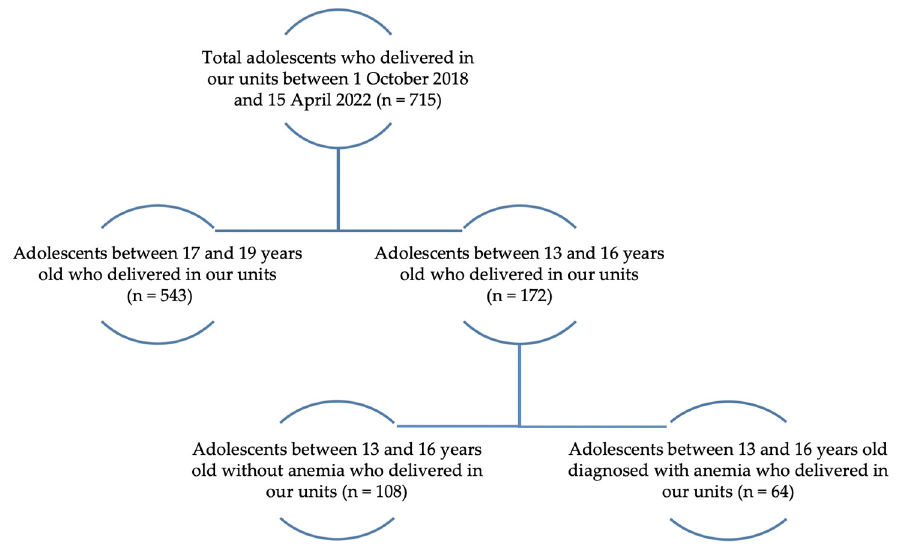
Figure 1. Flowchart of the distribution of the patients in the study.